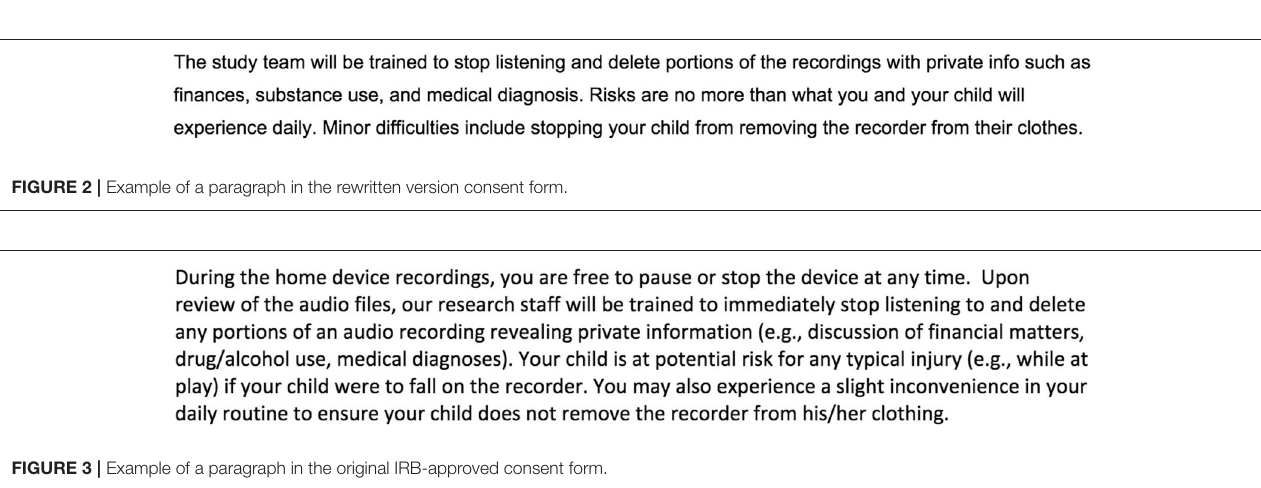
Frontiers in Digital Health |